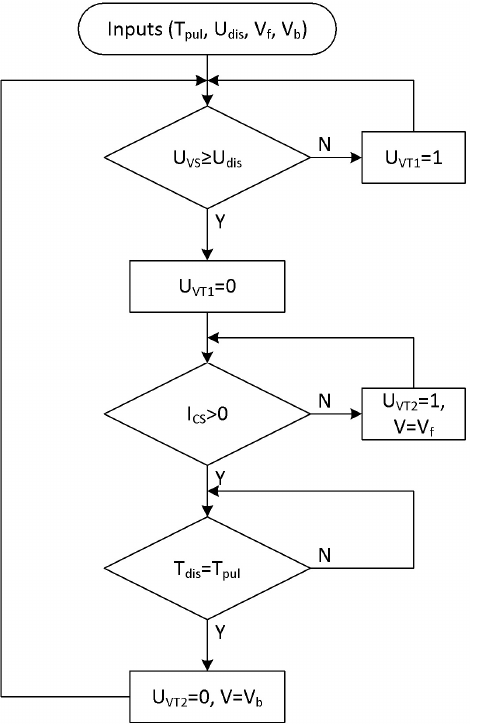
Figure 2. Block diagram of a duration control electric discharges algorithm.